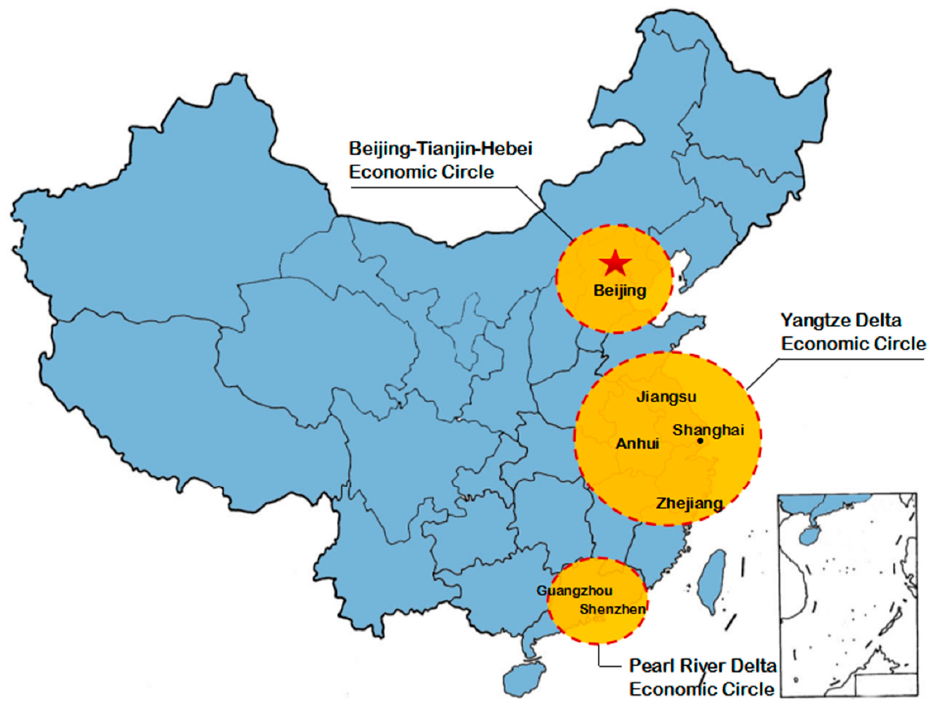
Figure 3. Location map of the Yangtze River Delta region, China.